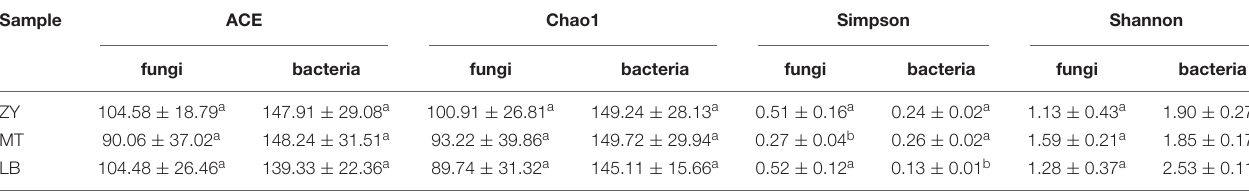
TABLE 2 | Richness and diversity of bacteria and fungi at different processing stages.